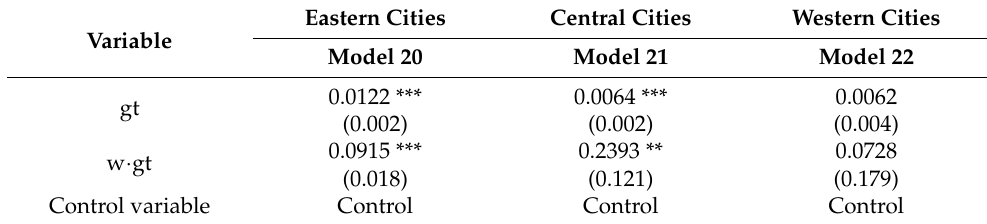
Table 10. Heterogeneity analysis results (Regions).